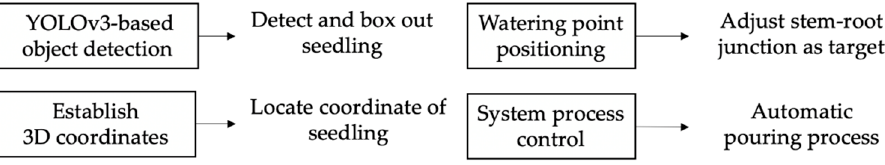
Figure 3. Functional blocks of the proposed visual recognition system.